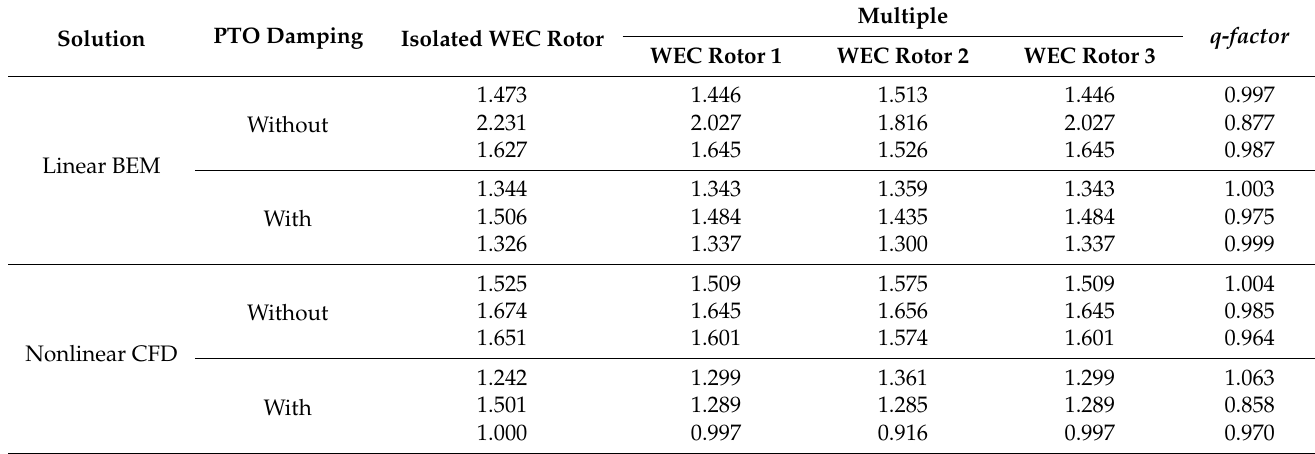
Table 3. Comparison of pitch RAO with and without PTO for linear BEM and nonlinear CFD results.